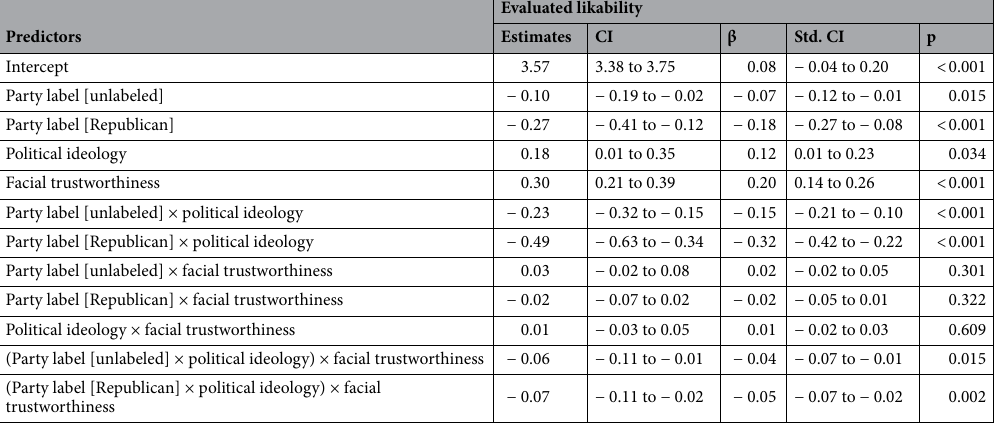
Table 2. Mixed effects model predicting likability in experiment 1.